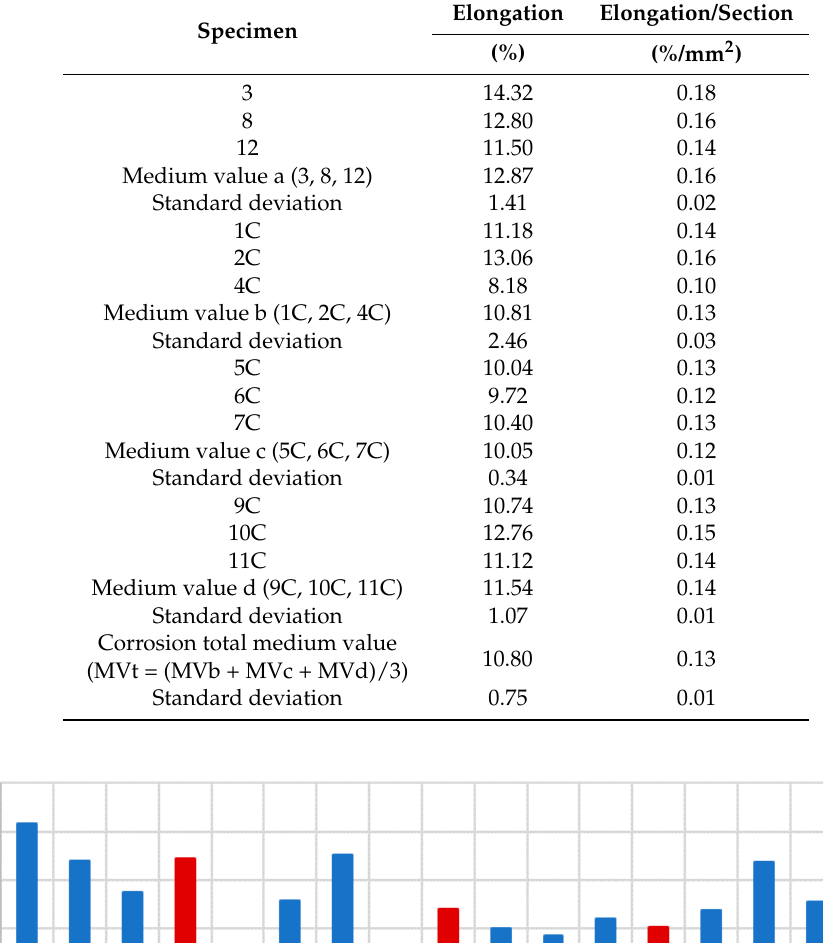
Table 6. Elongation at break and elongation at break/section relation values per specimen and medium values.